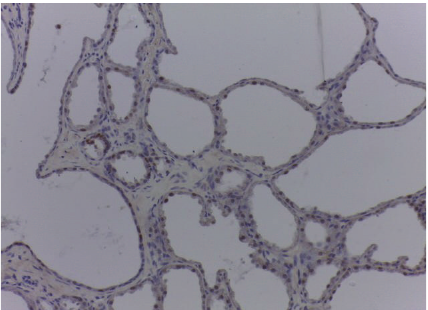
Figure 1: Encapsulated oval tissue with lobulated grayish white cut surface.